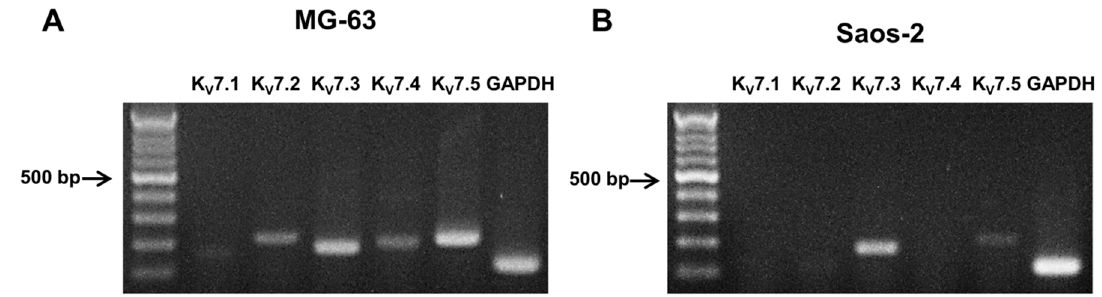
Figure 2. RT-PCR analysis of the K V 7 channels in osteoblast-like cells. The PCR products using cDNA from the MG-63 ( A ) and Saos-2 cells ( B ) were electrophoresed in a 1.6% agarose gel ( n = 5).